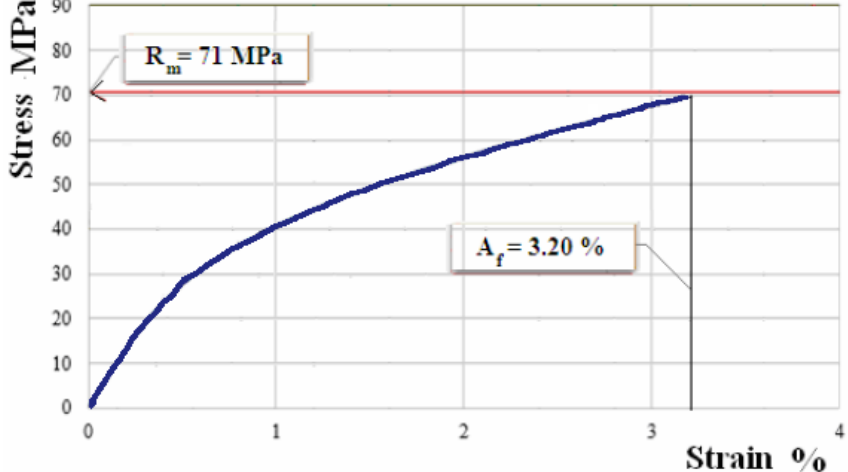
Figure 8. Characteristic curve for sample of composite material with matrix of hybrid resin of type 2, reinforced with fabric of first